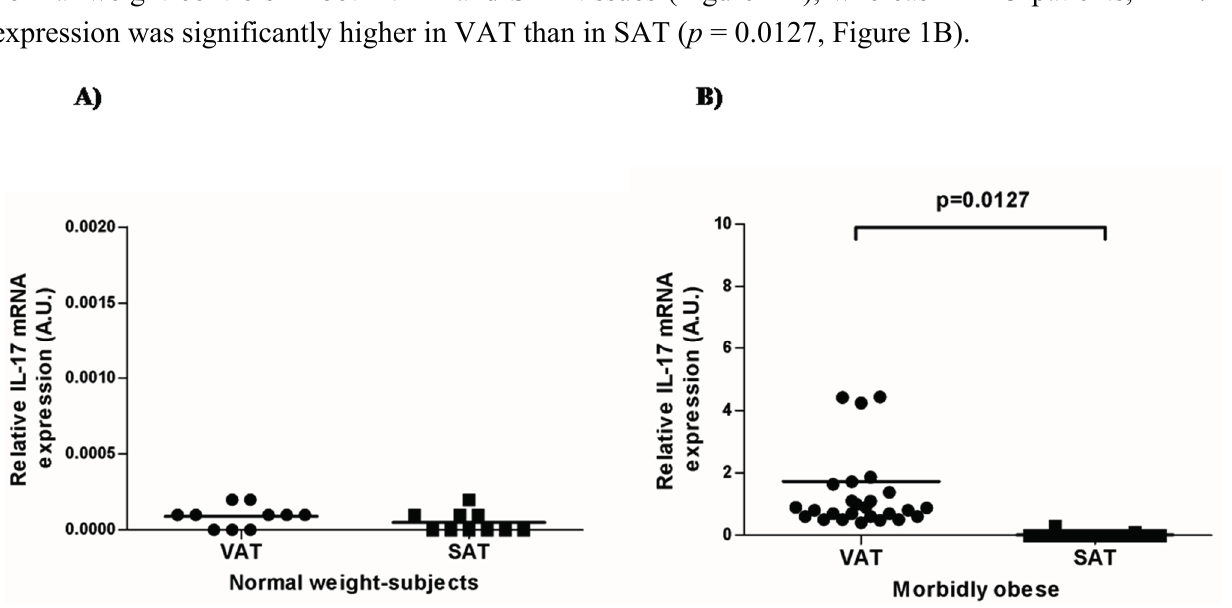
Figure 1. IL-17A mRNA expression in visceral and subcutaneous adipose tissues in normal-weight subjects ( A ) and morbidly obese women ( B ). AU: arbitrary units × 10 4 ; VAT: visceral adipose tissue; SAT: subcutaneous adipose tissue. Student’s t -test was used to compare the gene expression in the two groups. Results are shown as the mean ± SD. p < 0.05 is considered statistically